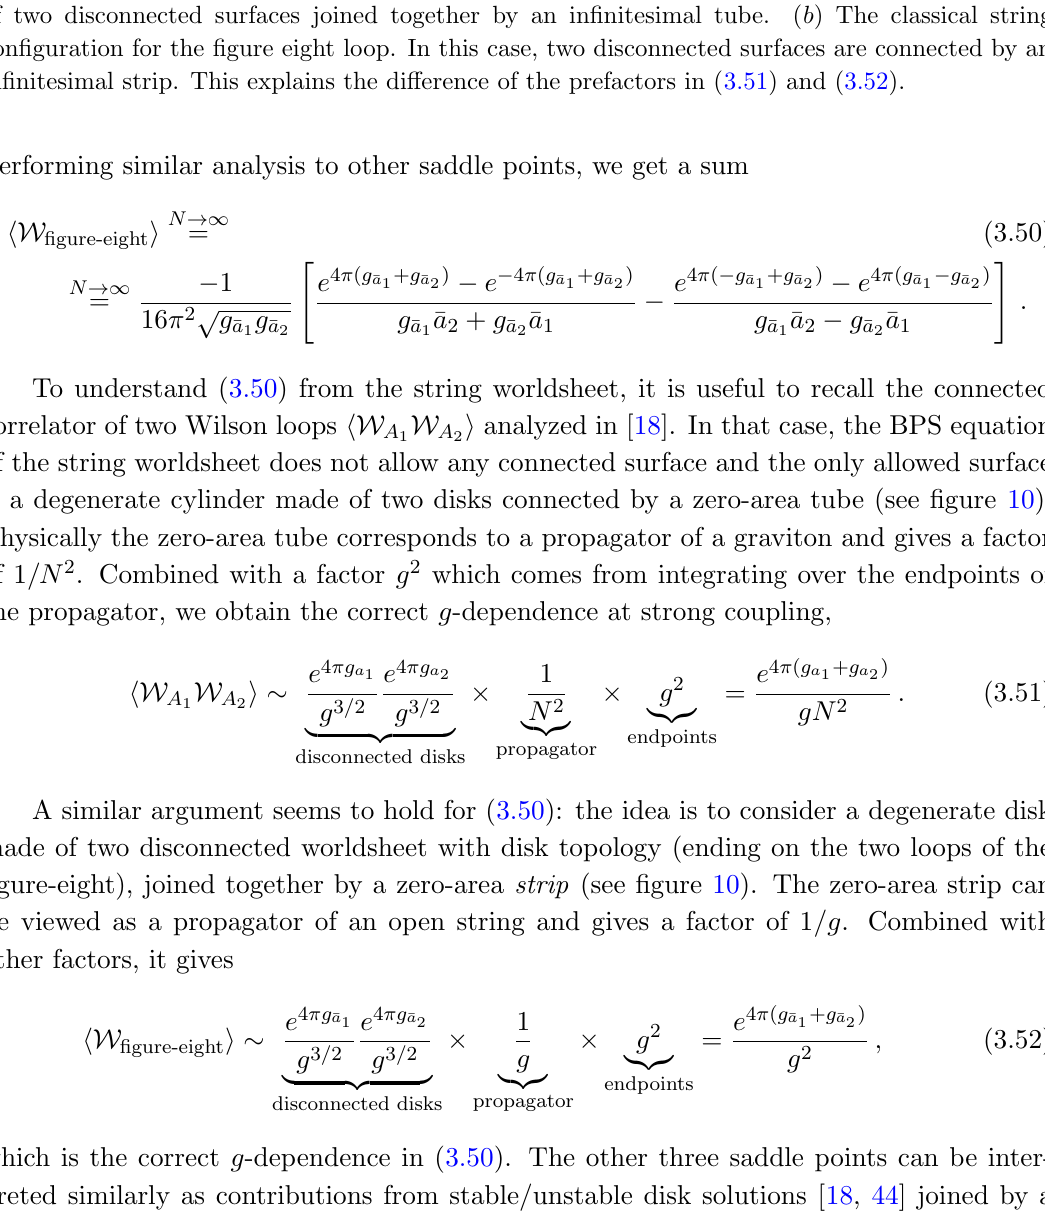
W A i . It consists 1 2